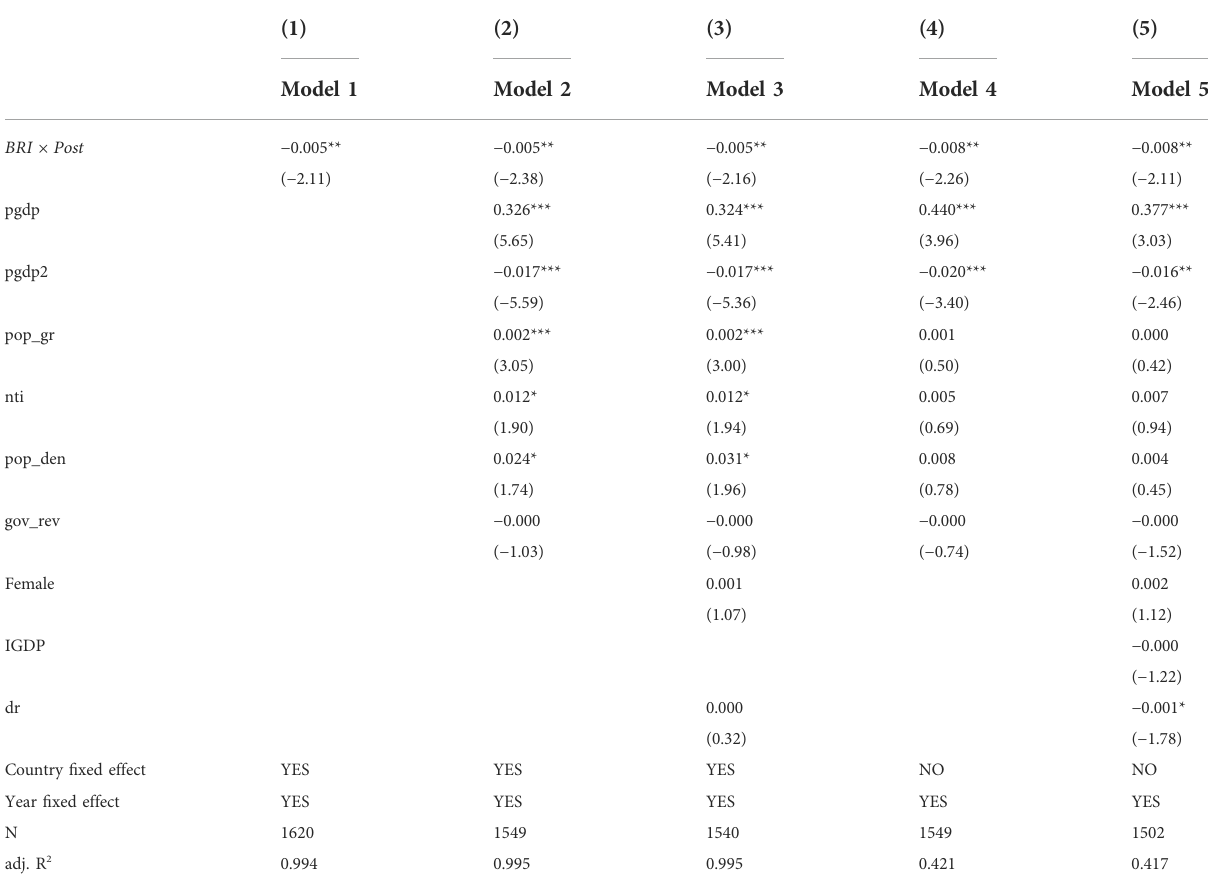
TABLE 4 Effects of the Belt and Road Initiative on environmental quality: Robust standard